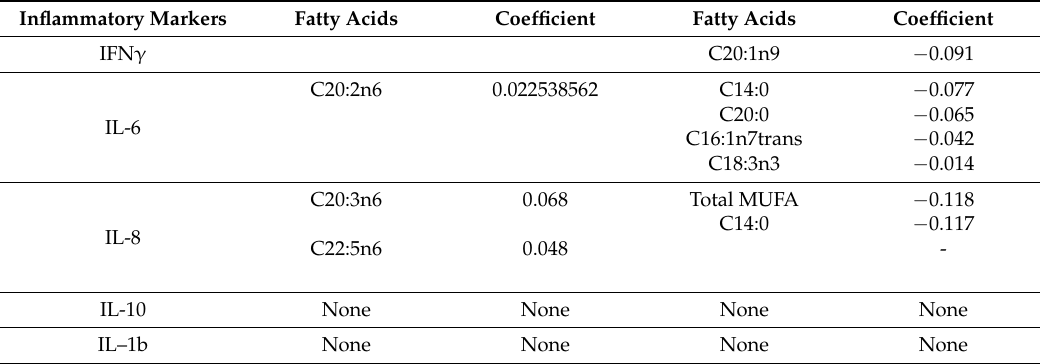
Table 3. Fatty acids ranked from the highest to the lowest elastic net positive or negative regression coefficients for inflammatory markers at baseline ( n = 282).